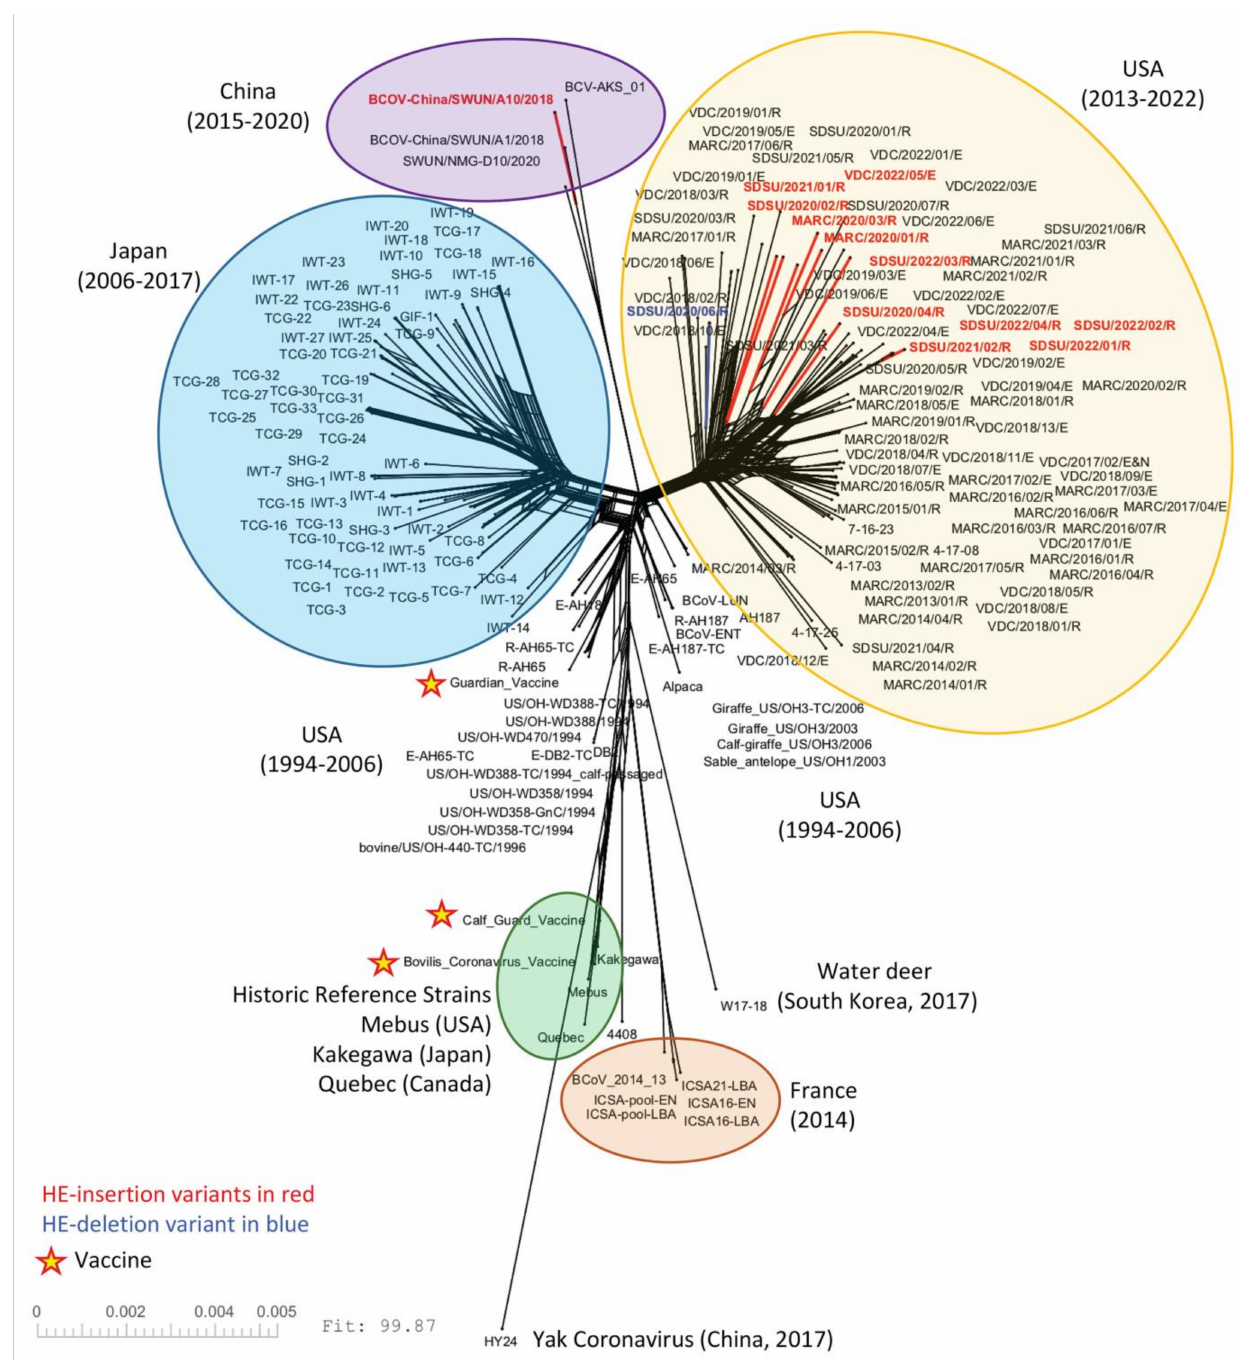
Figure 2. SplitsTree NeighborNet phylogenetic network of 192 BCoV genomes. The complete coding region of 192 genomes was aligned using MAFFT and analyzed with SplitsTree6. A list of the genomes used in this analysis can be found in Table S2. HE-insertion variants are in red and the single HE-deletion variant is in blue. The three vaccine strains are marked with a